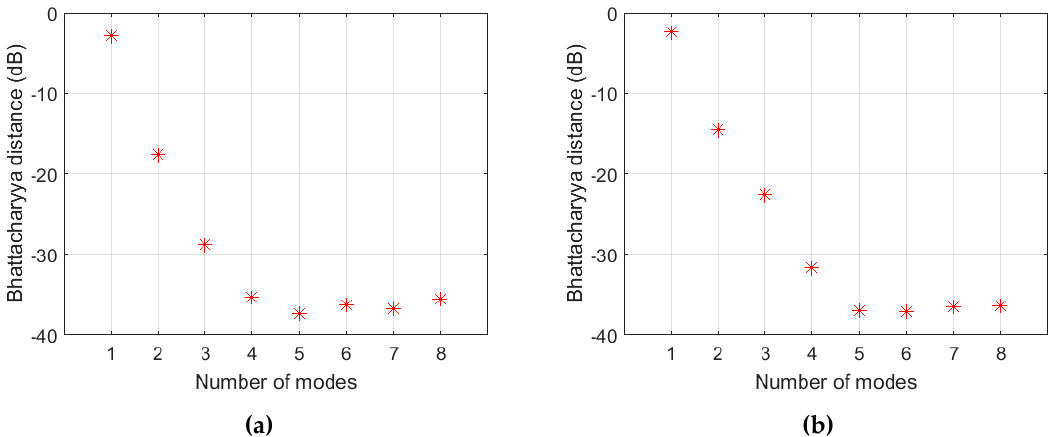
Figure 9. Bhattacharyya distance (dB scale) for the 3MD distribution using different numbers of modes with the NetRAD data, S-band, bistatic configuration, 60° bistatic angle. ( a ) HH polarization (Run 4), ( b ) VV polarization (Run 1). Table 6. 3MD distribution: minimum number of modes required to accurately match the NetRAD data.